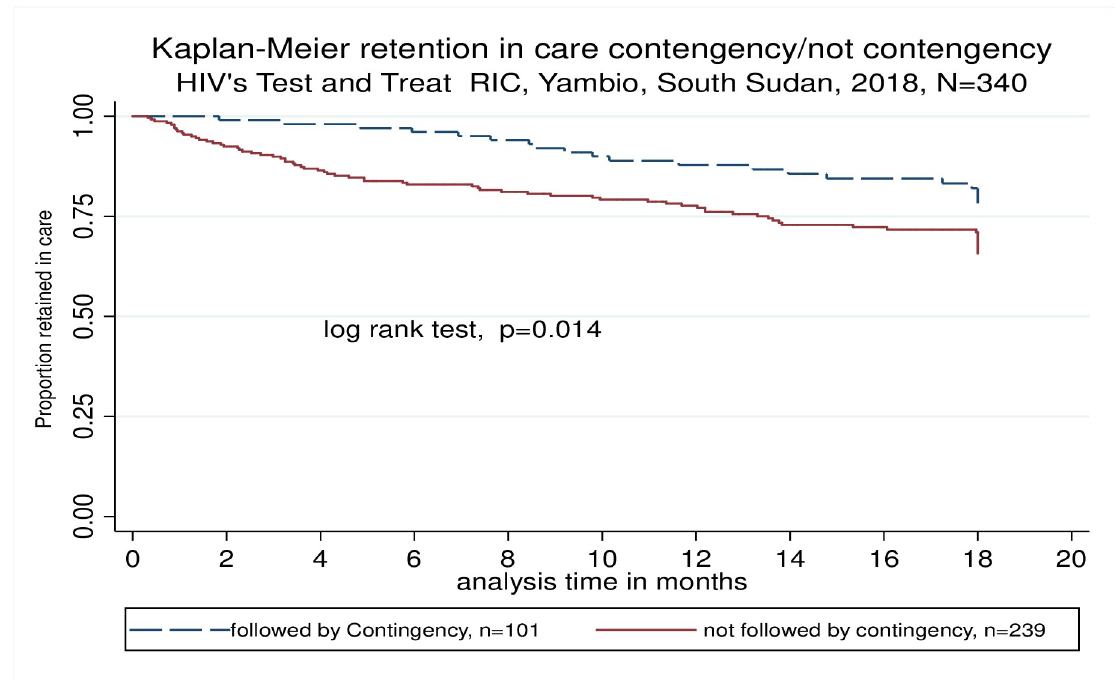
Fig 7. Retention in care for patients on contingency plan compared to patients under regular follow